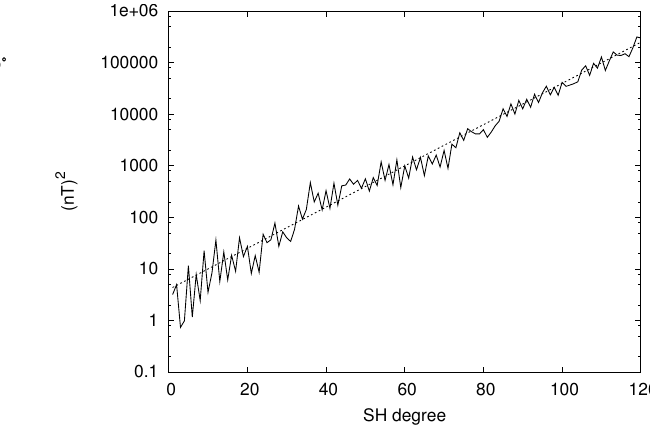
Fig. 2. Left: Mapping at r 0 = 6371 . 2km of the model defined in Eq. (14) where ı 1 random variables χ 1 m have a variance defined in Table 1 using v η = M . Right: Associated power spectrum. The dashed line is proportional ) 2 l . to ( r r 0